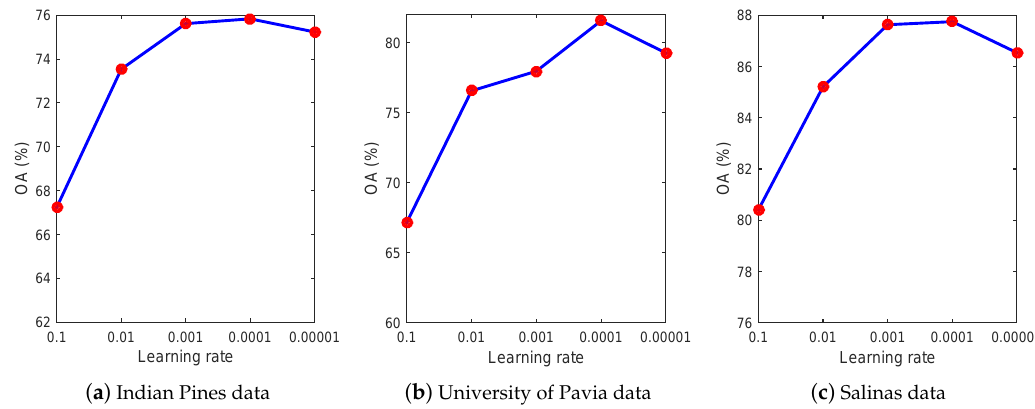
Figure 16. The impact of learning rate on the OA in ( a ) Indian Pines data, ( b ) University of Pavia data and ( c ) Salinas